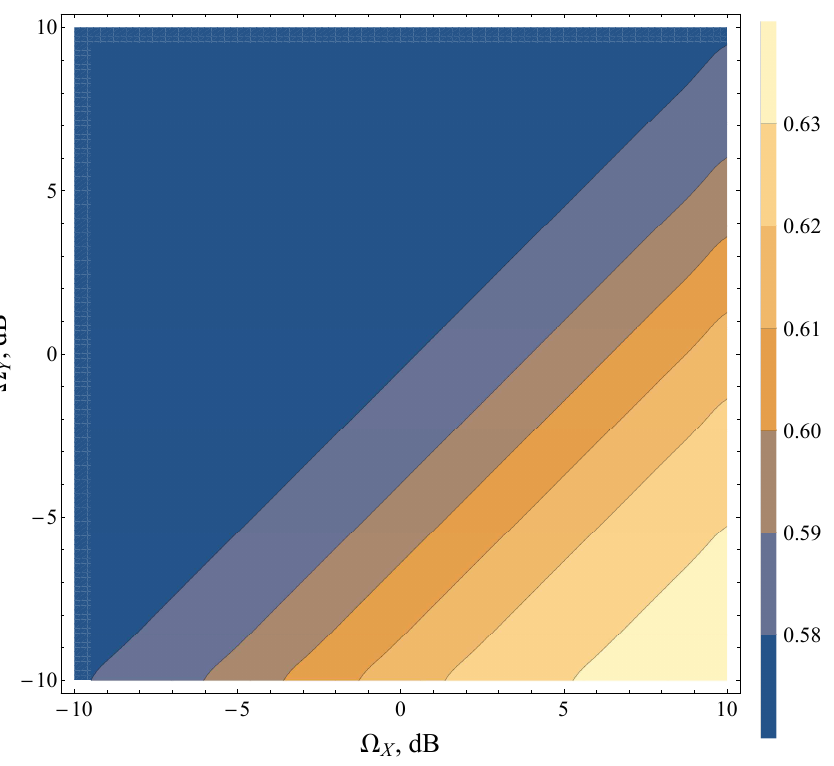
Figure 7. Average AUC contour map for the Beaulieu-Xie shadowed model for various Ω X , Ω Y and ¯ γ = 0 dB, u = 2, m X = 0.1, m Y = 1.